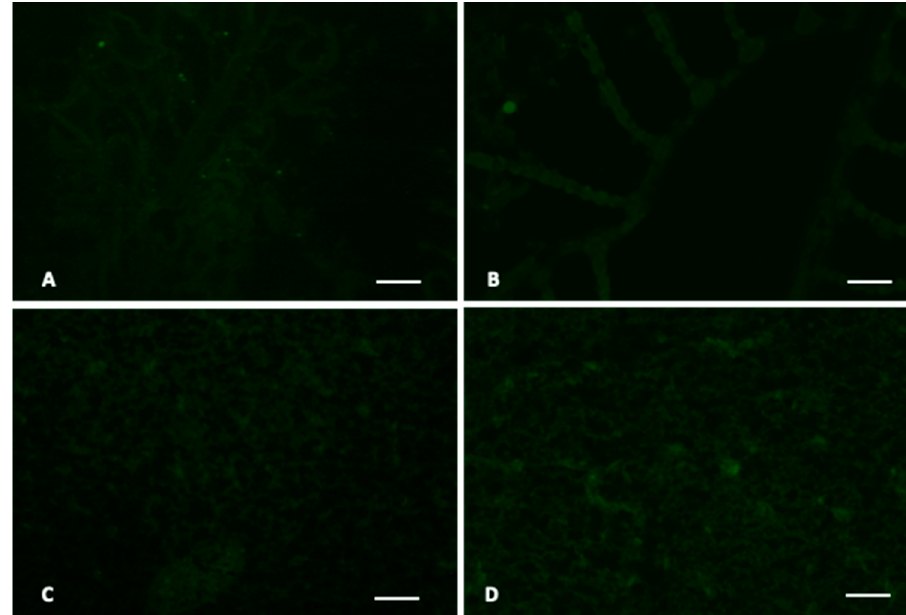
Figure 5. MT 1 expression in male gills ( A ) and liver ( C ). HSP70 expression in male gills ( B ) and in liver ( D ). Using specific antibodies anti-MT1 and anti-HSP70 it has been showed a weak expression of these proteins in cells (green). Scale bar A, C and D: 200 μ m; B: 50 μ m.